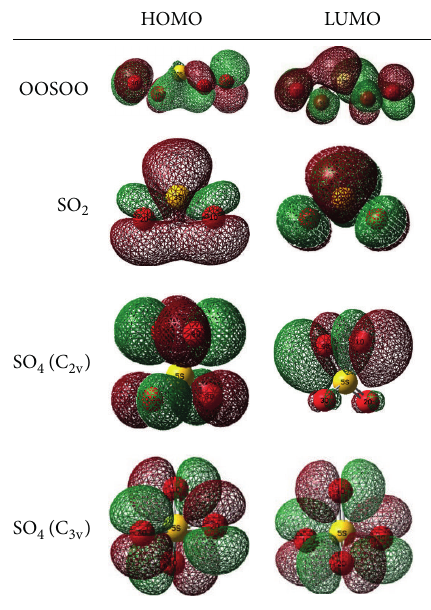
Figure 4: Frontier molecular orbitals of OOSOO, SO 2 , SO 4 (C 2 ) and SO 4 (C 3 v